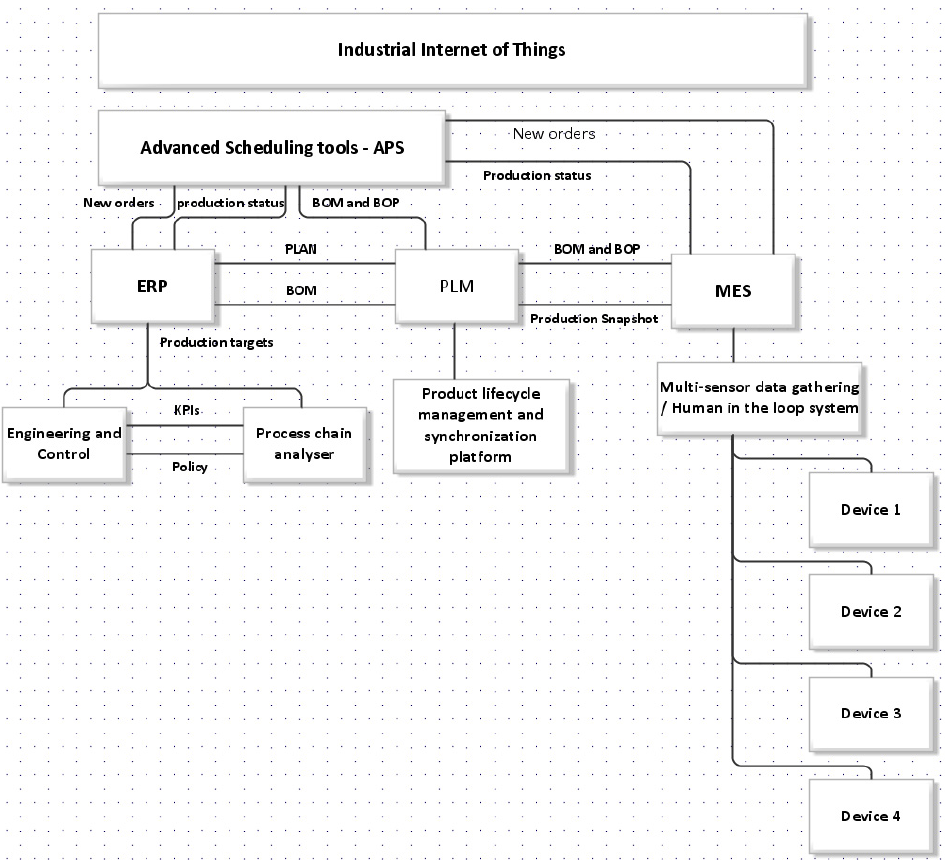
Figure 14. Zero-defect Manufacturing classical architecture extended by IIoT and Advance sched- Figure 14. Zero‑Defect Manufacturing classical architecture extended by IIoT and Advance uling.